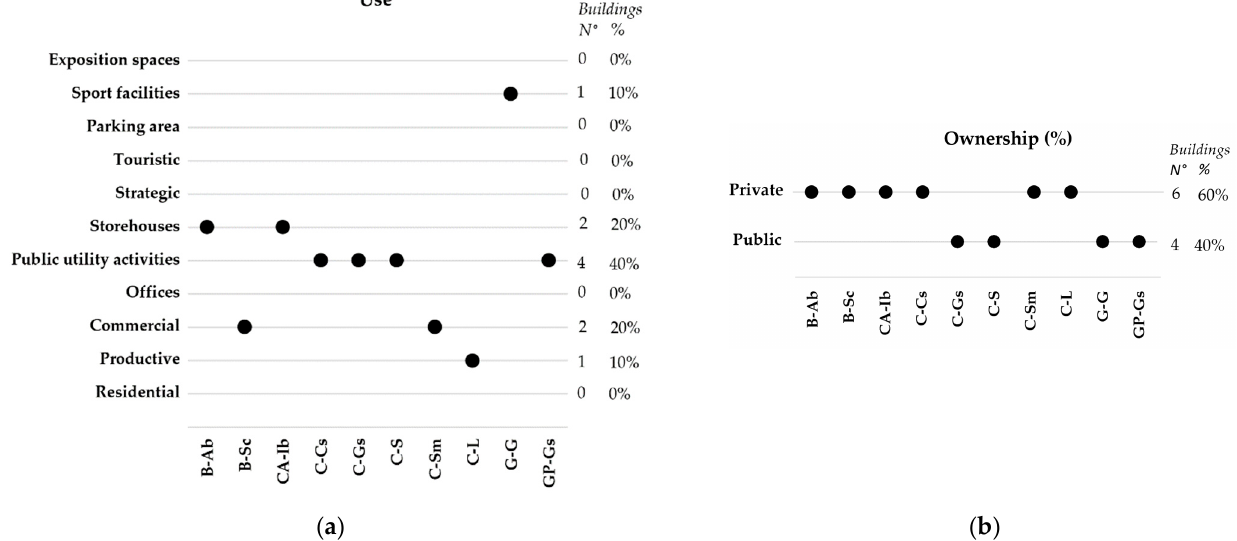
Figure 18. Section 2A CARTIS-Building. Use–Exposure: ( a ) Use; ( b ) Ownership.